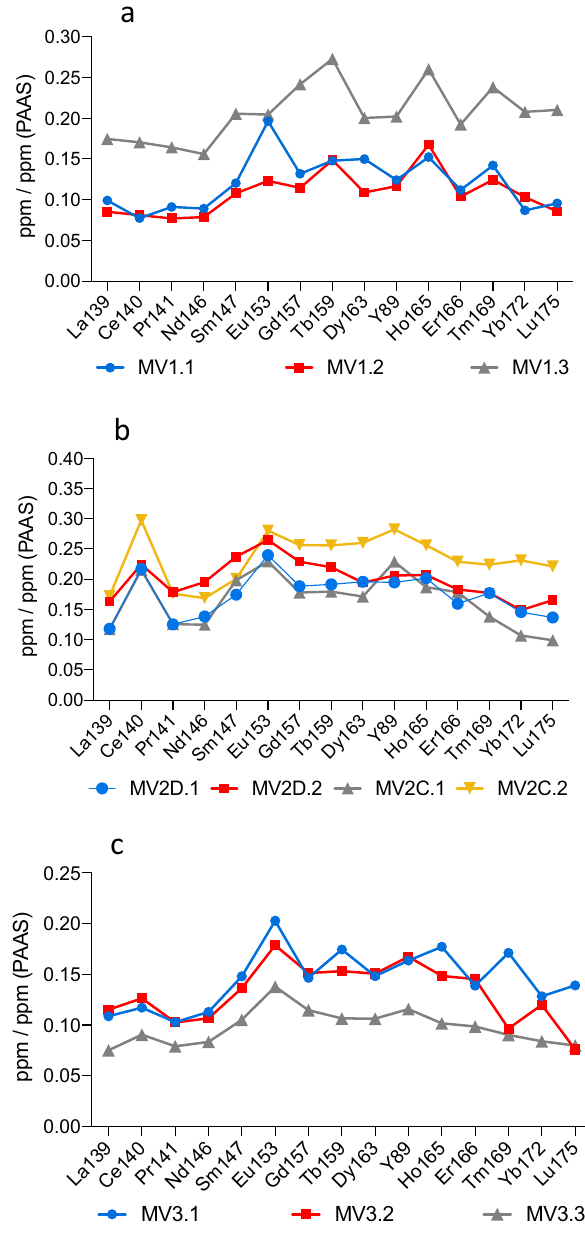
Figure 14. PAAS-normalized REY patterns for sub-samples of MV1 ( a ), MV2 ( b ), and MV3 ( c ). The results of MV1 represent the calcite matrix with microcrystalline dolomite, no differentiation between calcite and dolomite. MV2 shows distinctive results of calcite and dolomite separately and MV3 results represent the calcite